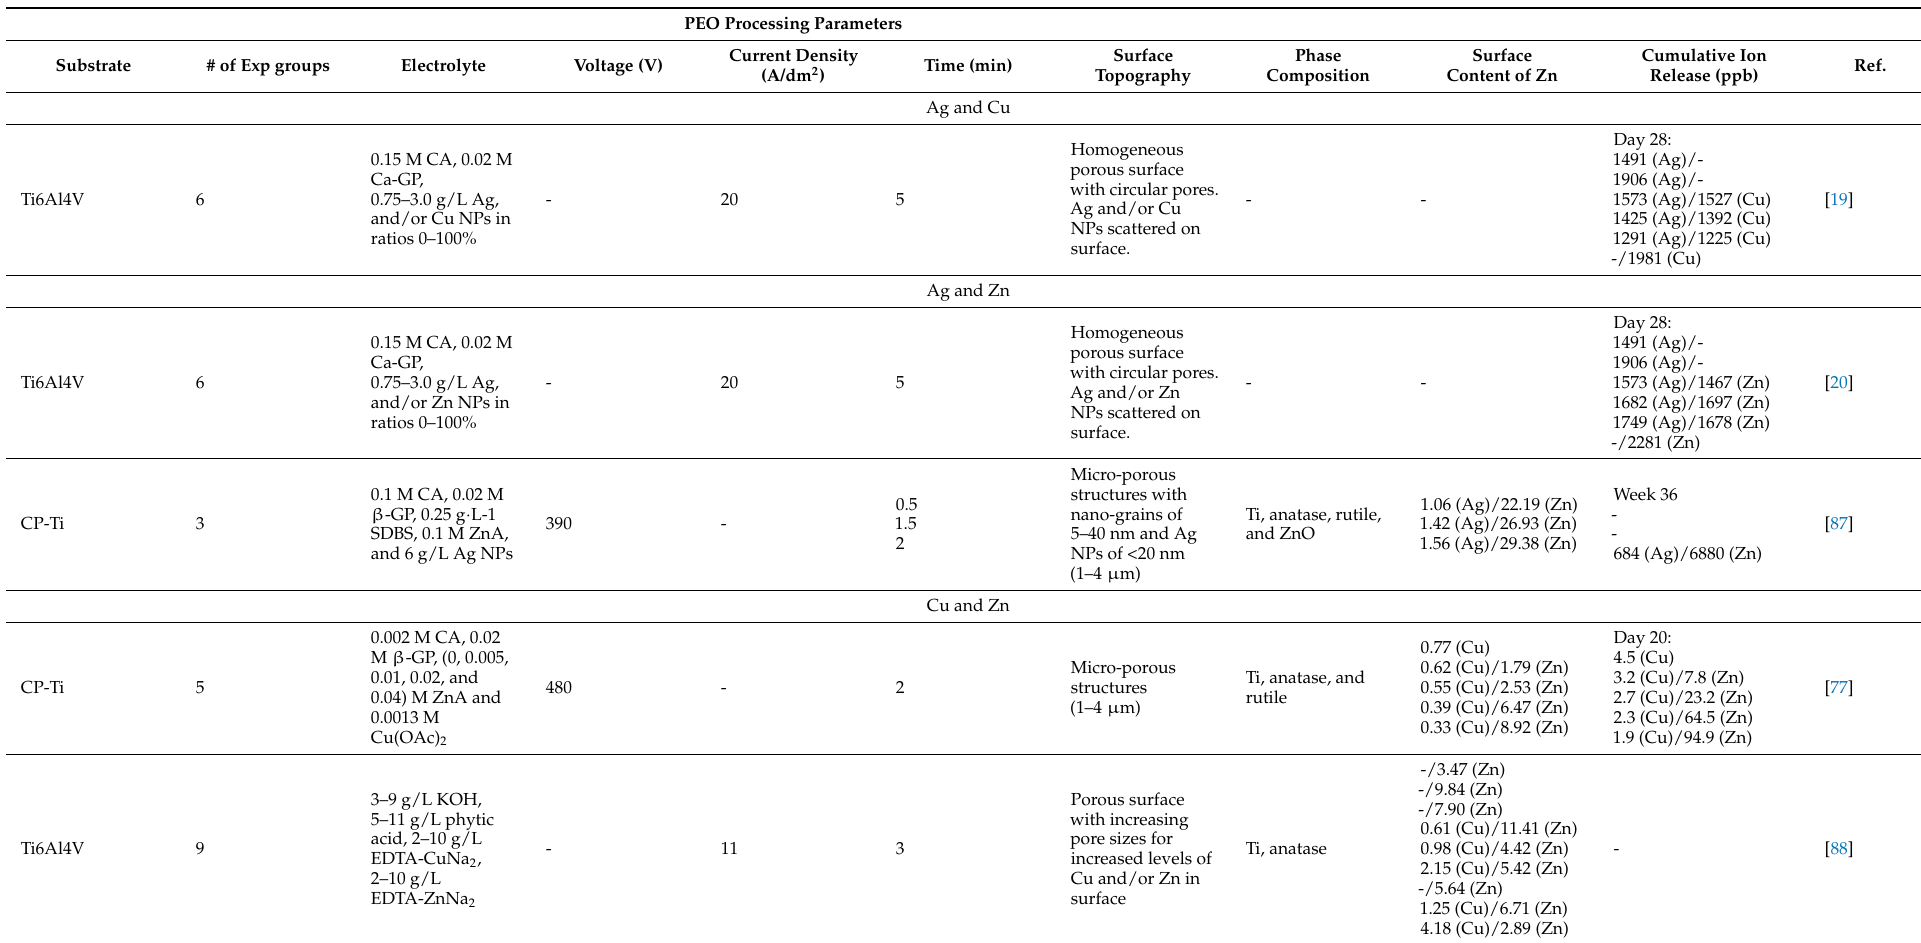
Table 4. The methodological details of the included studies in which multiple antibacterial agents were